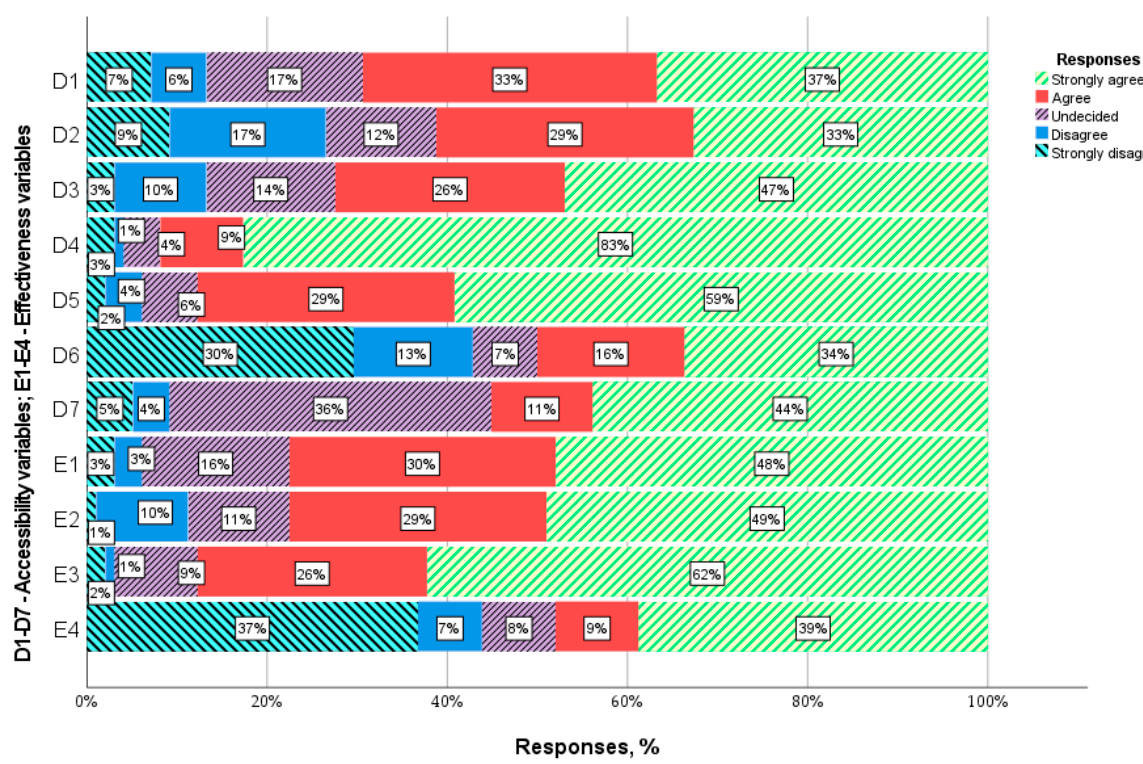
Figure 2. Distribution of accessibility and effectiveness responses.